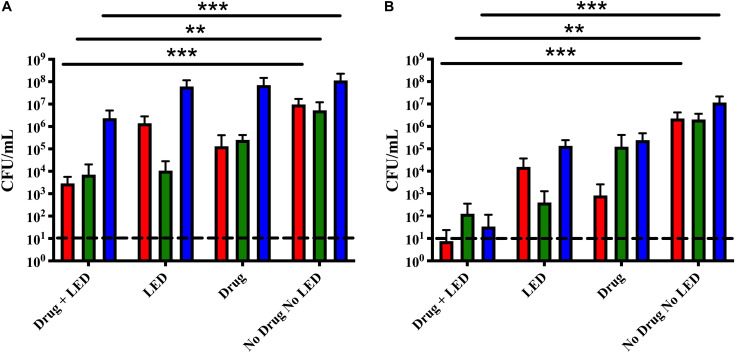
Successive aPDT treatments of dual and triple species biofilms improved treatment efficacy. (A) Single treatment. Biofilms were incubated for 15 min with 10 μM Ce6 followed by a 20 min 405 nm LED exposure. (B) Dual treatment. Biofilms were treated twice using the above parameters in two sequential cycles. Surviving biofilm-associated S. pneumoniae (red), M. catarrhalis (green), and NTHi (blue) were quantified by CFU enumeration. Dashed lines indicate the limit of detection. Statistically significant differences are denoted as **P < 0.01 and ***P < 0.001.